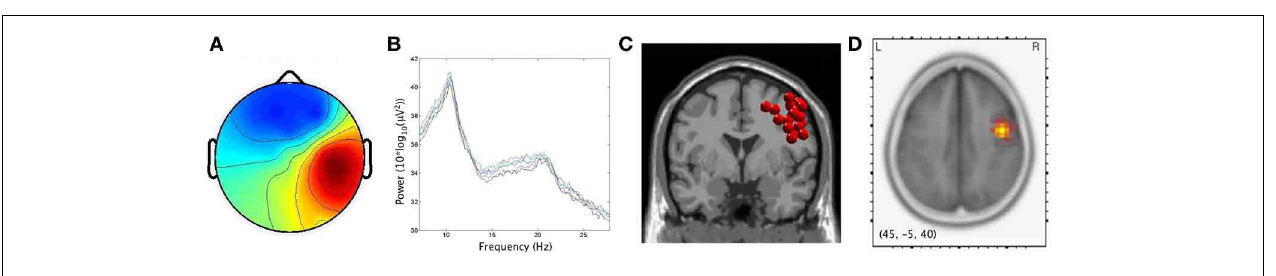
FIGURE 4 | Cluster results for right µ component. (A) mean scalp potential distribution (W − 1 ) scaled to RMS microvolts, (B) mean spectra of the components within the cluster for each condition, (C) distribution of